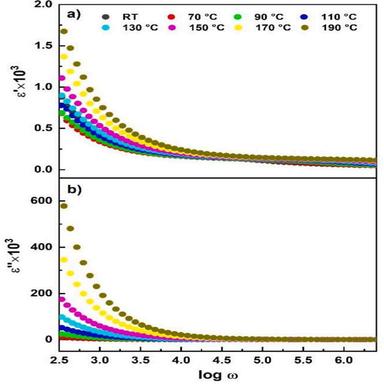
Variation of a) the real part, Ɛ′ and b) the imaginary part, Ɛ'' of permittivity with frequency for different temperatures.